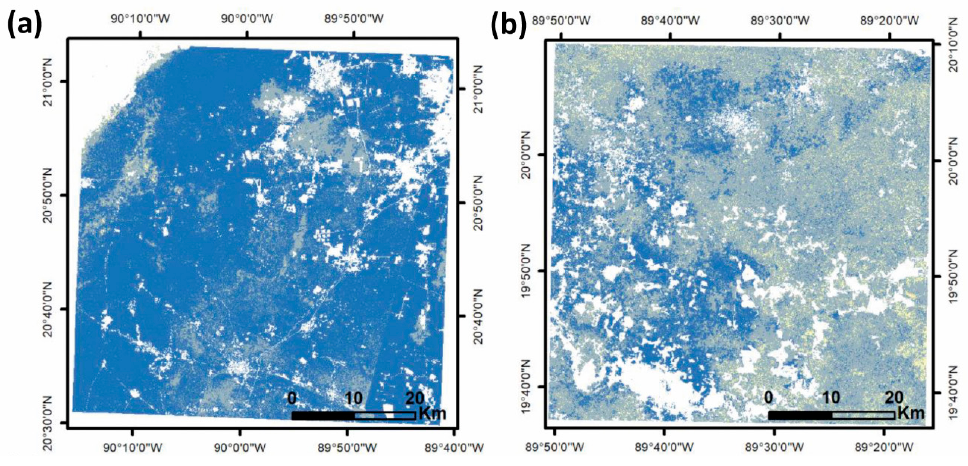
Figure 7. Deciduousness uncertainty maps for each vegetation type: ( a ) deciduous (El Palmar), ( b ) semi-deciduous (Kaxil Kiuic), and ( c ) semi-evergreen (Felipe Carrillo Puerto: FCP). 4. Discussion To our knowledge, this is the first study to map the canopy phenology of tropical dry forests and its uncertainty, as well as the spatial variation in deciduousness at coarse spatial scales, using satellite information at a fine spatial resolution (10 m). Most studies mapping deciduousness have used satellite imagery data with coarse spatial resolutions such as 250 m, 500 m, and 1 km [45]. A major finding of this research is that spectral bands, vegetation indices, spectral unmixing fractions, and texture metrics from high-resolution imagery are good predictors of tree species deciduousness of tropical dry forests along an environmental gradient that covers the most important forest ecosystems in the Yucatan Peninsula. The fit of our best model ( R 2 = 0.60) was comparable to that of the few previous studies relating high-resolution satellite imagery data and deciduousness: R 2 = 0.71 in Mediterranean natural habitats [46] and R 2 = 0.55 in a gradient of evergreen to deciduous tropical forests in Africa [19]. Moreover, the accuracy assessment of the best fitted model showed a good performance after validation using an independent data set with a deciduousness estimation accuracy of R 2 = 0.67 and RMSE = 14.4% (Table 3 and Figure 2). Knowledge of the spatial distribution of deciduousness is of paramount importance for the conservation, restoration, management, and ecosystem modeling of tropical dry forests because deciduousness exerts an important control on carbon and water fluxes [47,48]. This is because many tree species in tropical dry forests exhibit a distinctive leaf-deciduous phenology to cope with